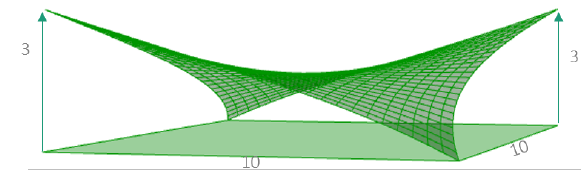
Figure 11: Initial mesh for form-finding